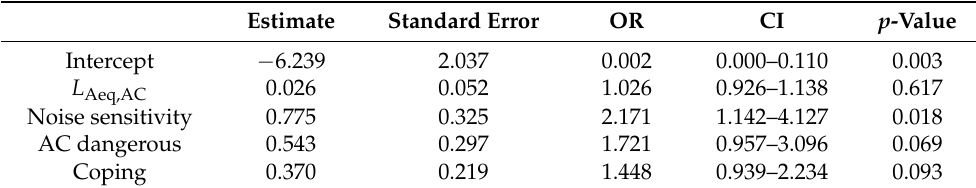
Table 4. Multiple logistic regression model LR2 with random effects for the prediction of aircraft noise-induced short-term annoyance of children. Acoustical variable: L Aeq,AC during time in bed. Adjusted Odds Ratios (OR) with 95% Confidence Intervals (CI) and p -values, AIC = 659.